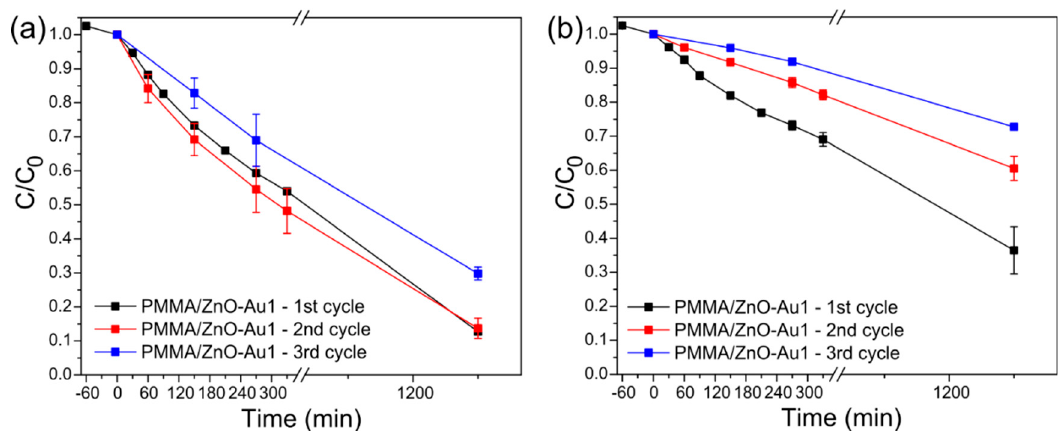
Figure 6. Photocatalytic degradation activity under UV light irradiation of ( a ) MB and ( b ) BPA for three consecutive cycles using the PMMA/ZnO-Au1.